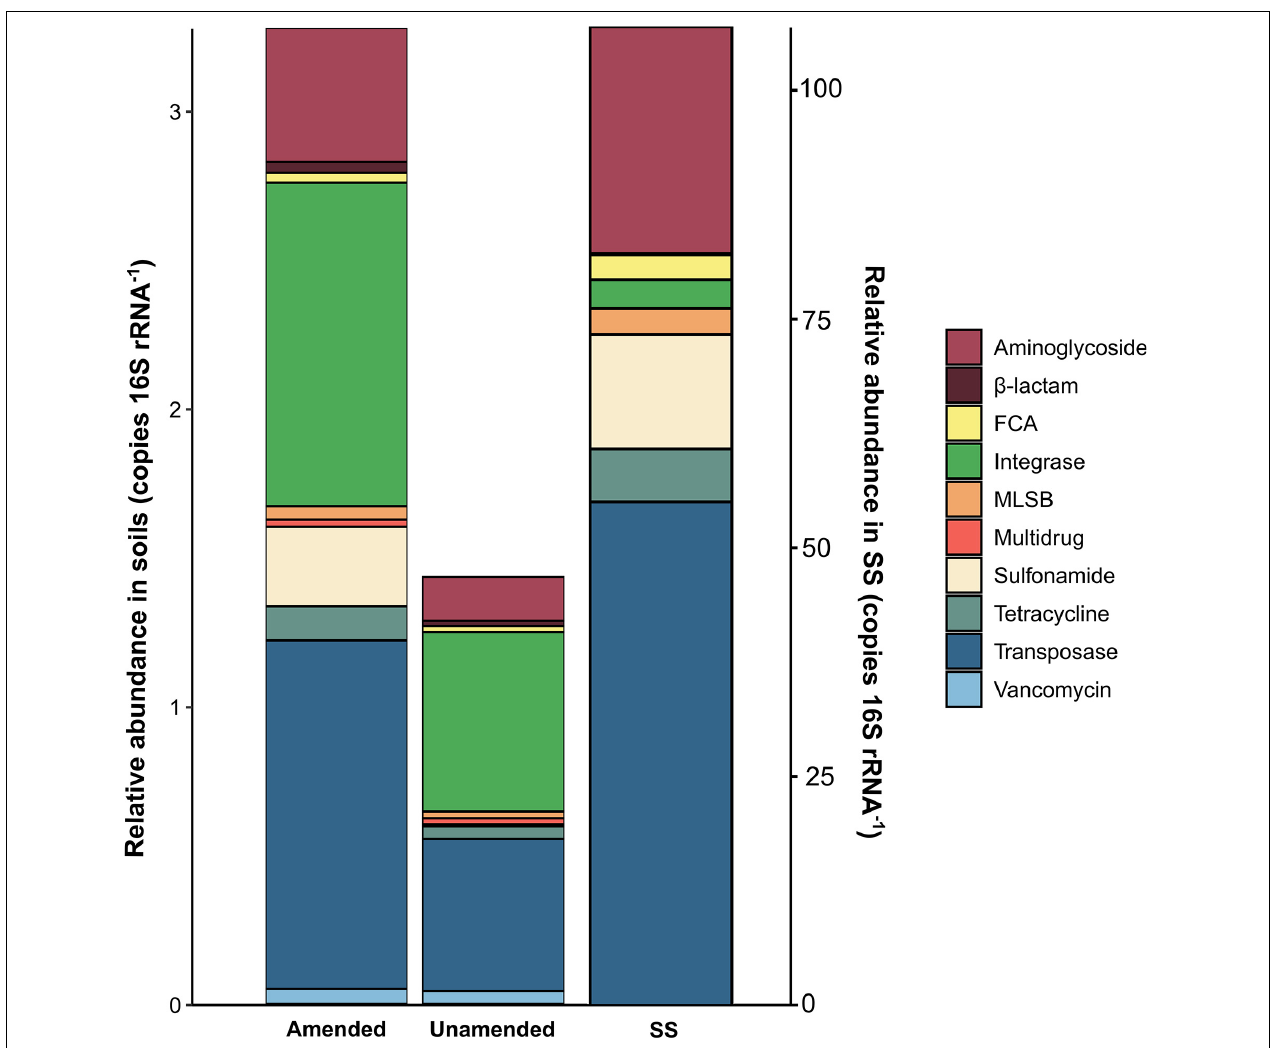
FIGURE 1 | Relative abundances of ARGs and MGE-genes in amended soils, unamended soils and